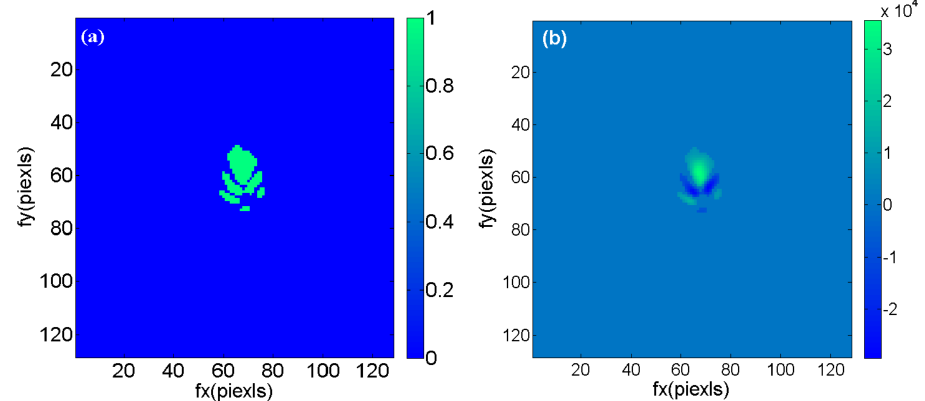
Figure 5. The filtered frequency distribution of Figure 4, where ( a ) is the window depending on the intensity of the WDF and ( b ) is the processed distribution.